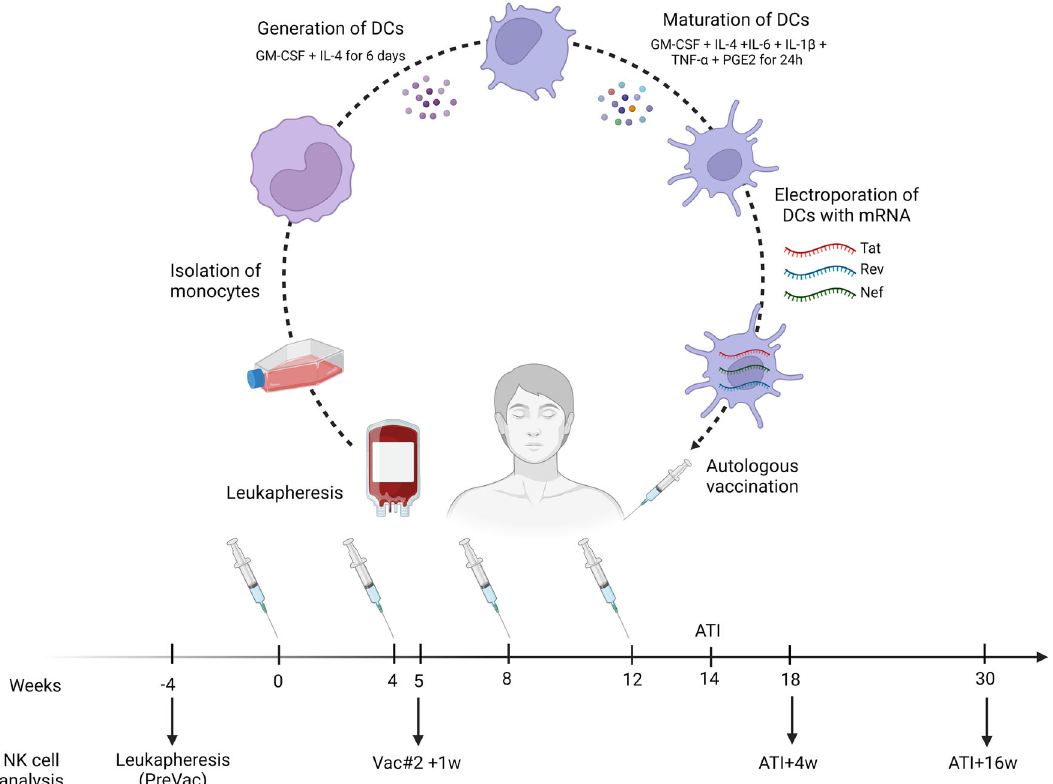
Fig. 1 Overview of the DC-TRN study. Four weeks prior to administration of the fi rst vaccine, a leukapheresis was performed from which monocytes were isolated and subsequently differentiated into DCs via culturing in X-vivo 15 medium supplemented with 1% heat-inactivated autologous plasma in the presence of GM-CSF and IL-4 for 6 days. On day 6, maturation of immature monocyte-derived DC was induced by the addition of a cytokine cocktail consisting of GM-CSF, IL-4, IL-6, IL-1 β , TNF- α and PGE2 for 24 h. Participants received 4 identical vaccines consisting of three autologous monocyte-derived dendritic cell preparations, electroporated with either Tat, Rev or Nef mRNA with intervals of 4 weeks. The vaccines were administered both subcutaneously and intradermally at three separate places (right arm, left arm and one thigh) to exclude immunodominance of one of the antigens. Two weeks after administration of the fi nal vaccine (week 14), participants were submitted to ATI. ART was restarted when considered necessary by the treating physician. Time points at which NK cell analysis was performed are indicated with arrows: before vaccination (PreVac), 1 week after the second vaccination (Vac#2 + 1w), 4 weeks after ATI (ATI + 4w) and 16 weeks after ATI (ATI + 16w). Figure created with